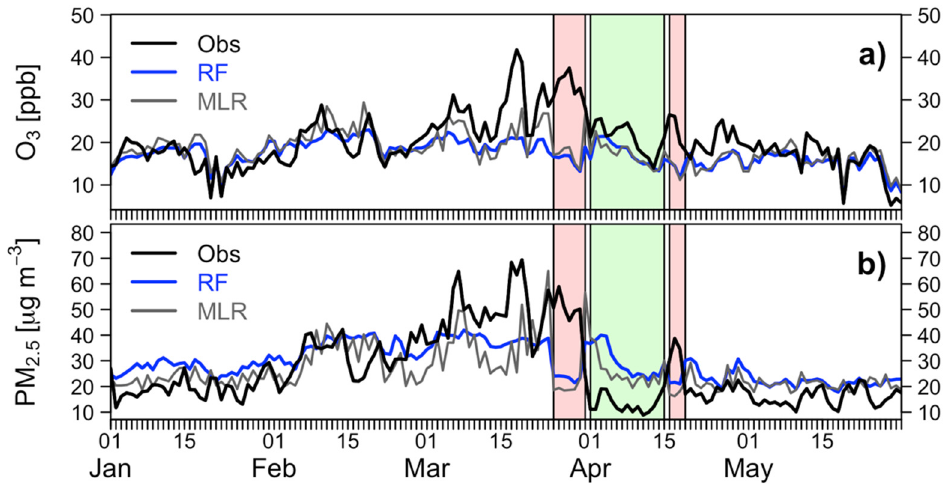
Figure 5. Time series of daily observed and predicted values from 1 January to 31 May 2020. ( a ) PM 2.5 ; ( b ) O 3 . Predictions with the random forest (RF) and multiple linear regression (MLR) models. Values averaged over all available stations. Table 2. Mean observed and predicted (“business as usual”) pollutant concentrations during the periods of interest, and the 2016–2019 reference period. Values averaged over all available stations.